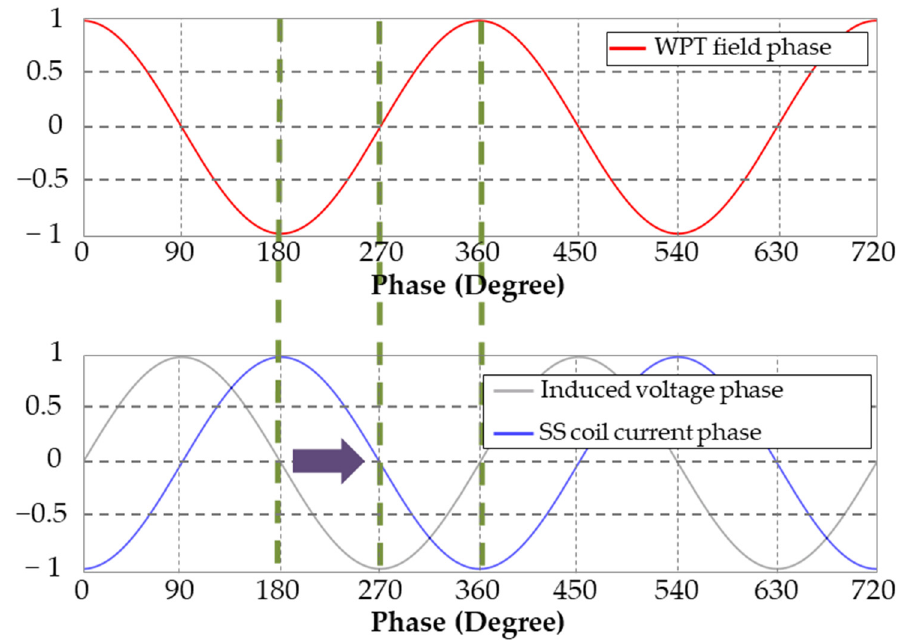
Figure 6. Induced voltage and current phases of the SS coil whose impedance has been adjusted to operate in an inductive region for leakage magnetic field shielding.